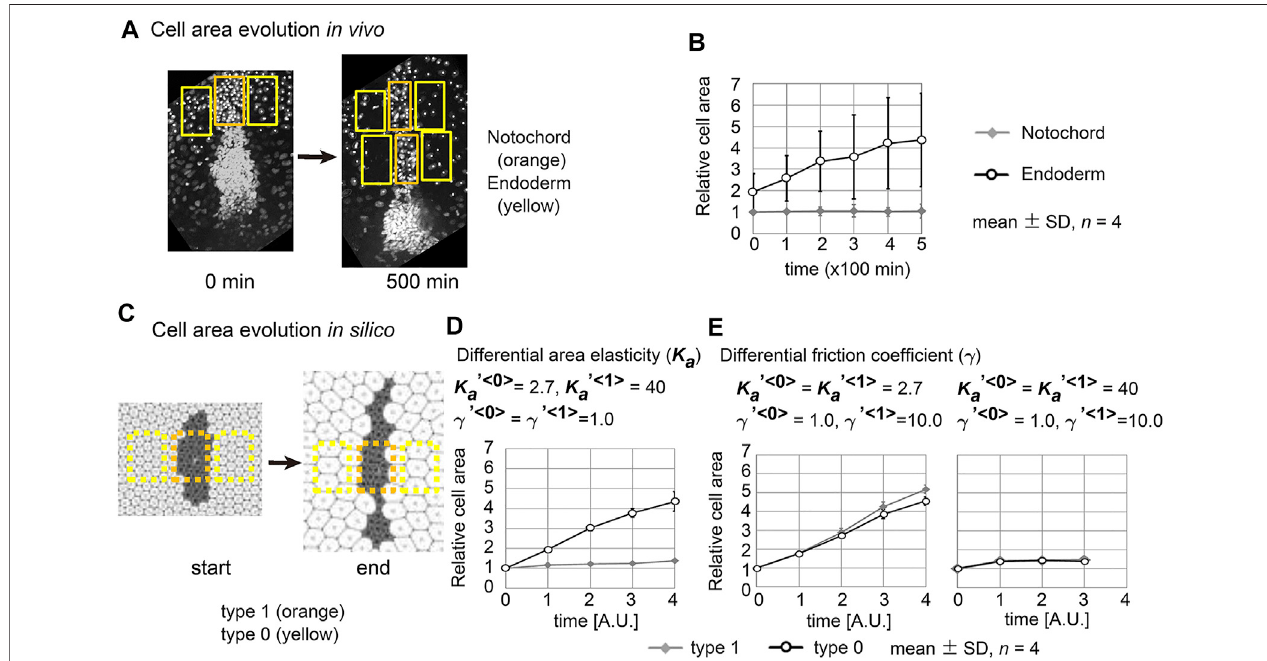
FIGURE 6 | Cell behaviors in mouse notochord and their comparison with two theories. (A) Confocal microscopic images at two time points in the mouse notochord and the surrounding endoderm are shown. Nuclei of the cells were visualized by histone 2B fused to EGFP. The orange and yellow rectangles are regions used for measuring cell areas within the notochord and endoderm, respectively. These microscopic images were obtained from our previous work (Imuta et al., 2014). (B) The cell areas in the notochord and endoderm are shown with their temporal evolutions. The mean cell area in the notochord at 0 min was de fi ned as 1.0. Four embryos were analyzed ( n = 4). (C) Cell areas in simulations were measured. Simulation outcomes are indicated with orange and yellow rectangles that were used to measure cell areas in a similar manner to B. (D) Cell areas obtained with differential area elasticities, which were derived from the simulation outcomes in Figure 2C ( K ′ < 1 > (cid:1) 40 ) , are shown. Four different initial con fi gurations of the simulations ( n = 4) were applied. Parameter values for area elasticities and coef fi cients of friction are a alsoindicated. (E) Cellareasobtainedwithdifferentialfrictioncoef fi cients,whichwerederivedfromthesimulationoutcomesin Figure5 ; SupplementaryFigureS5 ,are shown in a similar manner to (D) . The values from type 1 and type 0 cells are nearly identical in the right panel.